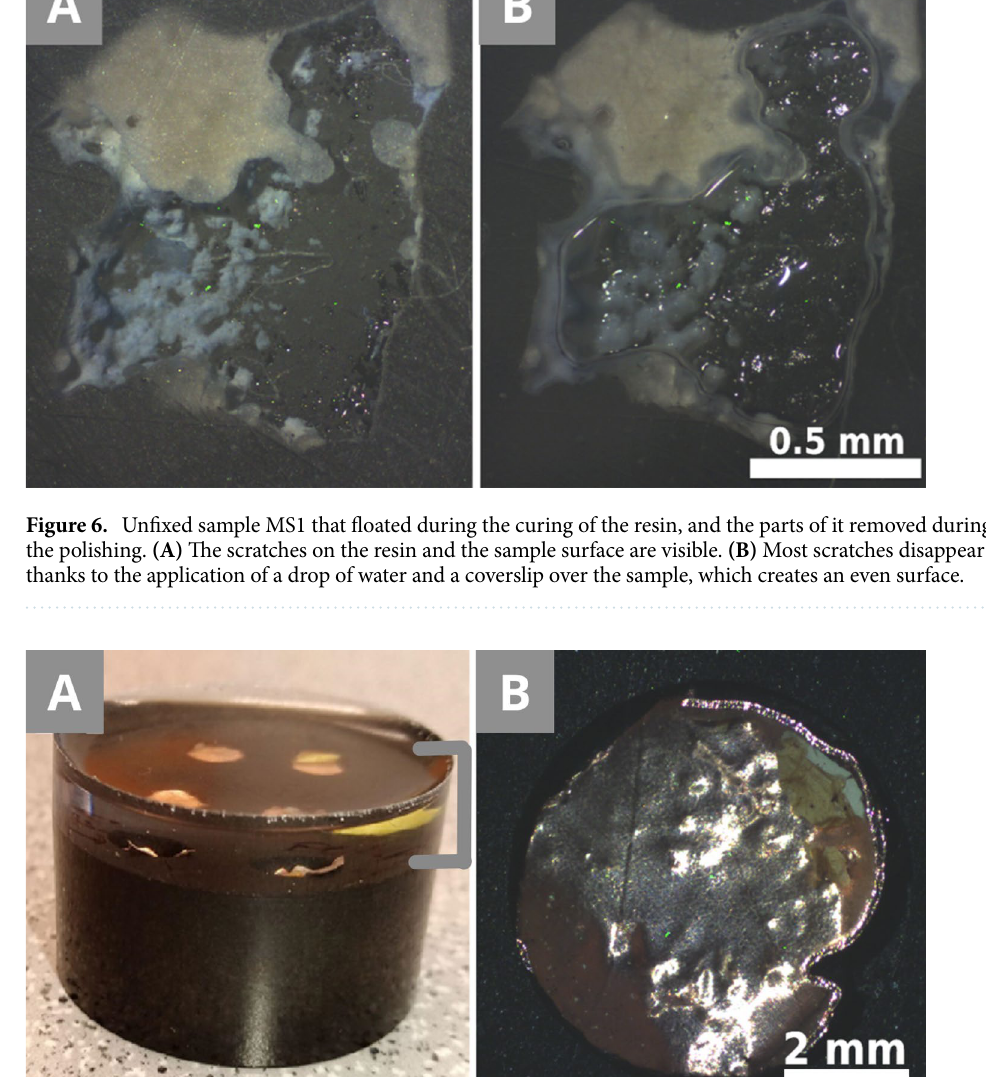
curing time because of the relatively large amount of the resin, and the charging of the cross-section under the SEM beam. With the flat-embedding preparation, which was used for Preparation B, the positioning was easier,